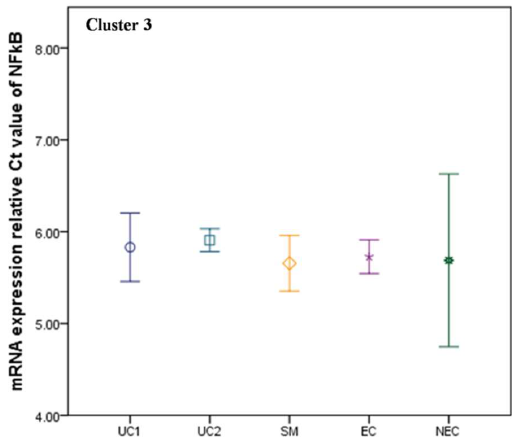
Figure 3. NF- κ B expression was not much influenced following malaria burden in any of the clinical subgroups and was grouped in Cluster 3 separately. Uncomplicated malaria1 (UC1 = parasitemia < 25,000 / µ L), uncomplicated malaria2 (UC2 = parasitemia > 25,000 / µ L), severe malaria (SM), endemic control (EC), non-endemic control (NEC). β -actin was used as an endogenous control. Mean and standard error bars were calculated at 95% confidence interval (CI). Gene expression decreases as Ct value increases and vice versa.